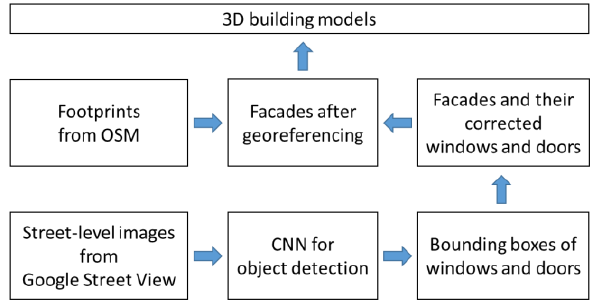
Figure 4. The framework of 3D building reconstruction for creating the input data.